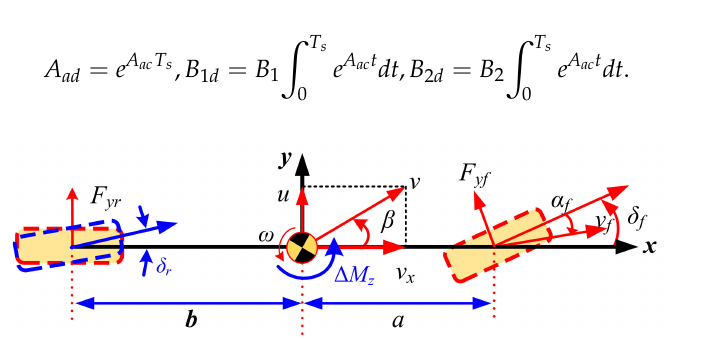
Figure 2. Two-DoF control model.